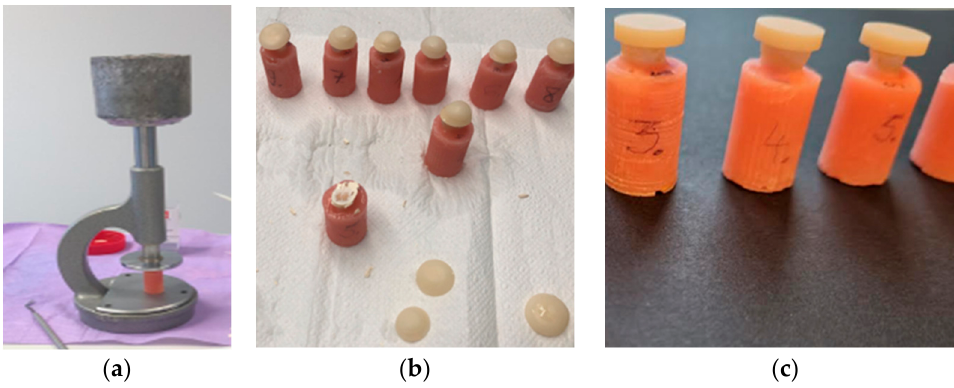
Figure 4. ( a ) Customized press (15N) for temporary overlay cementation. ( b ) Process of temporary cementation. Removal of temporary overlays and cement residues. ( c ) Specimens after adhesive cementation.